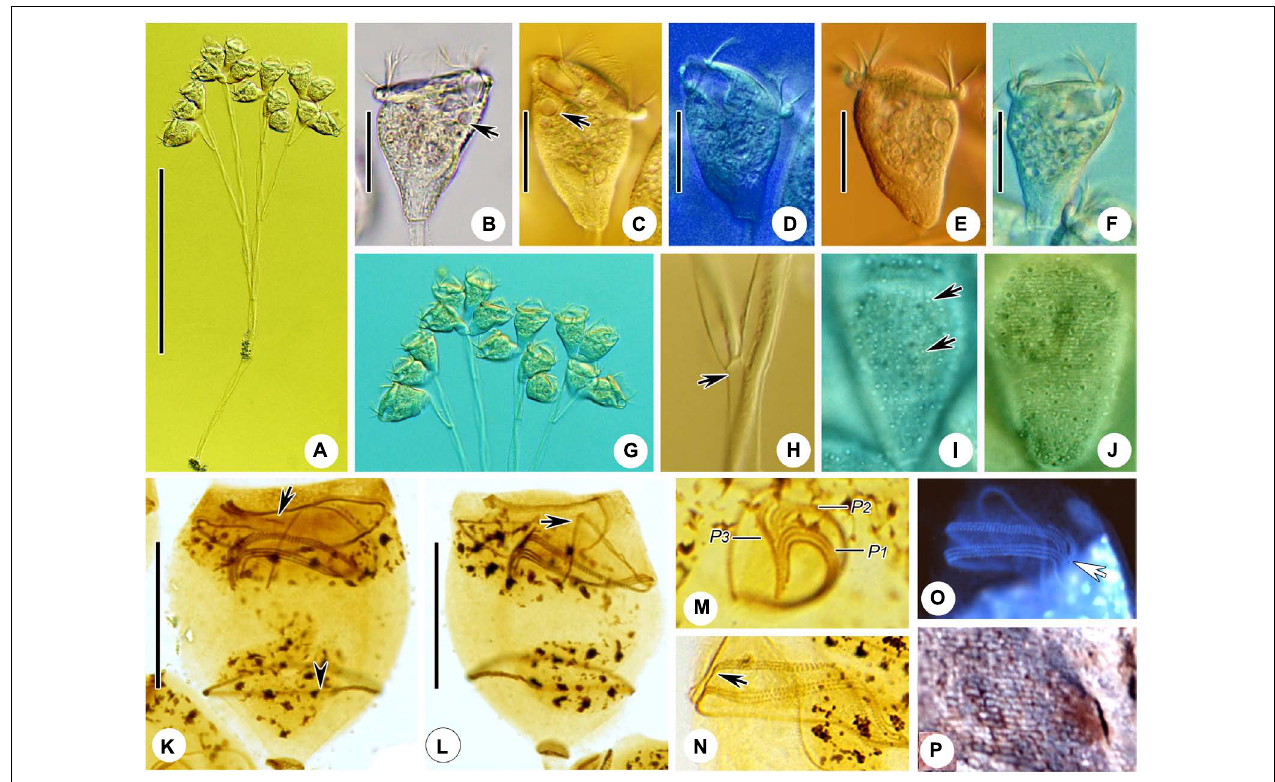
FIGURE 9 | Photomicrographs of Epicarchesium sinense n. sp. in vivo (A–J) , after protargol staining (K–O) , and after “dry” silver nitrate staining (P) . (A) A mature colony. (B–G) Different zooids showing the shape variation; arrows mark the contractile vacuole. (H) Detail of the stalk; arrow marks the discontinuous spasmoneme. (I) Detail of the pellicle; arrows mark the tubercles. (J) Reticulate pellicle. (K,L) Two protargol-stained zooids showing the infraciliature; arrow in panel (K) marks the epistomial membrane, arrowhead in panel (K) marks the trochal band, and arrow in panel (L) marks the haplokinety. (M) Infundibular polykineties 1–3 (P1–3). (N) Part of the oral ciliature; arrow marks the abstomal end of P2. (O) Part of the oral ciliature (image processed by the reverse function via Photoshop); arrow marks P3. (P) Silverline system. Bars: 250 µ m in panel (A) , 30 µ m in panels (B–F) , and 20 µ m in panels (K,L) .